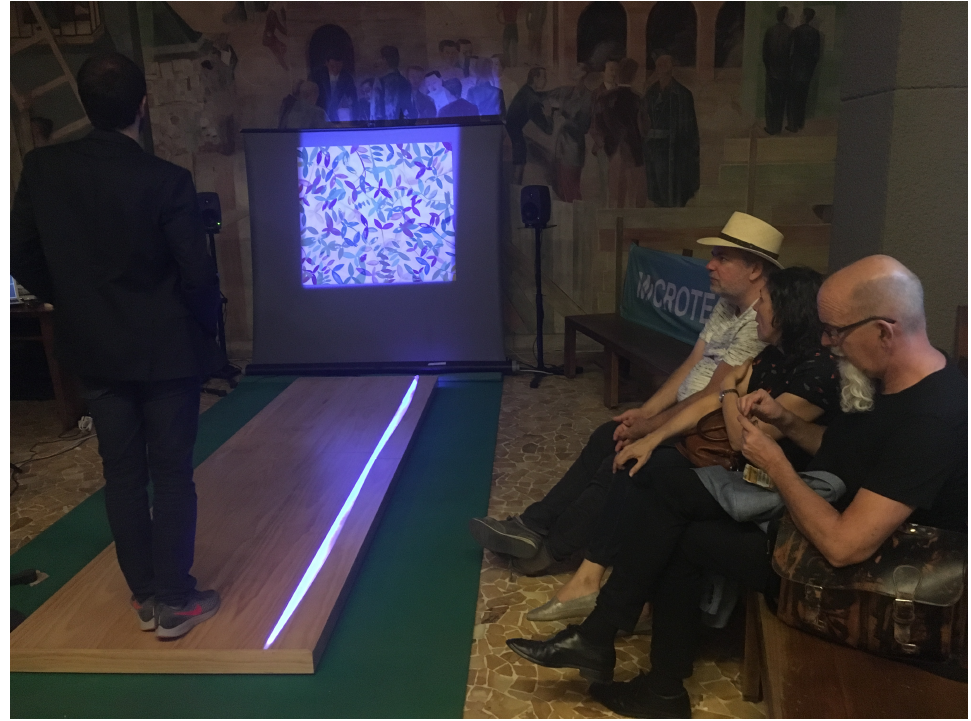
Figure 6. The interactive sonorization of a painting of Hartwig Thaler (first person on the right) at the European Researchers Night